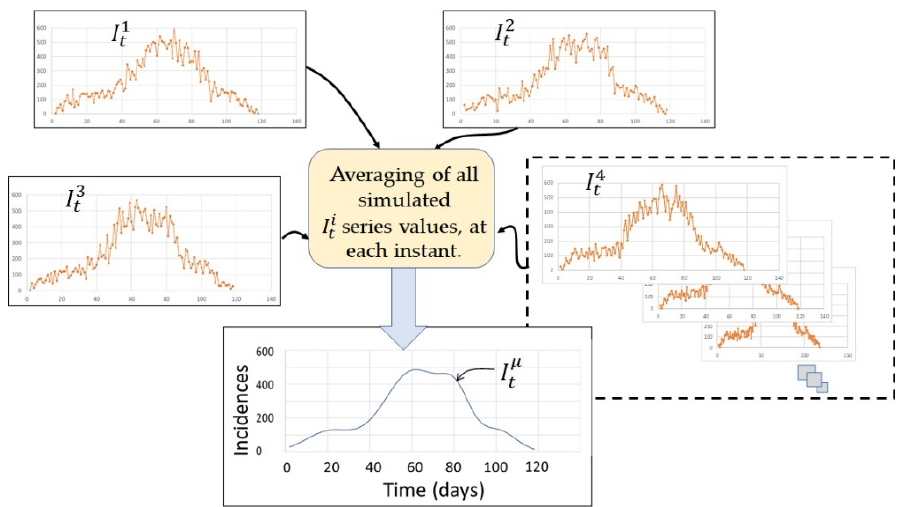
Figure 4. Typical plot of 𝑤 (cid:3046) factors vs serial interval constructed based on a gamma distribution. The main parameter values (k and λ ) of the distribution can be defined by calculus based on the provided mean ( 𝜇 (cid:3046) ) and standard deviation ( 𝜎 (cid:3046) ), which should be obtained by experimentation.